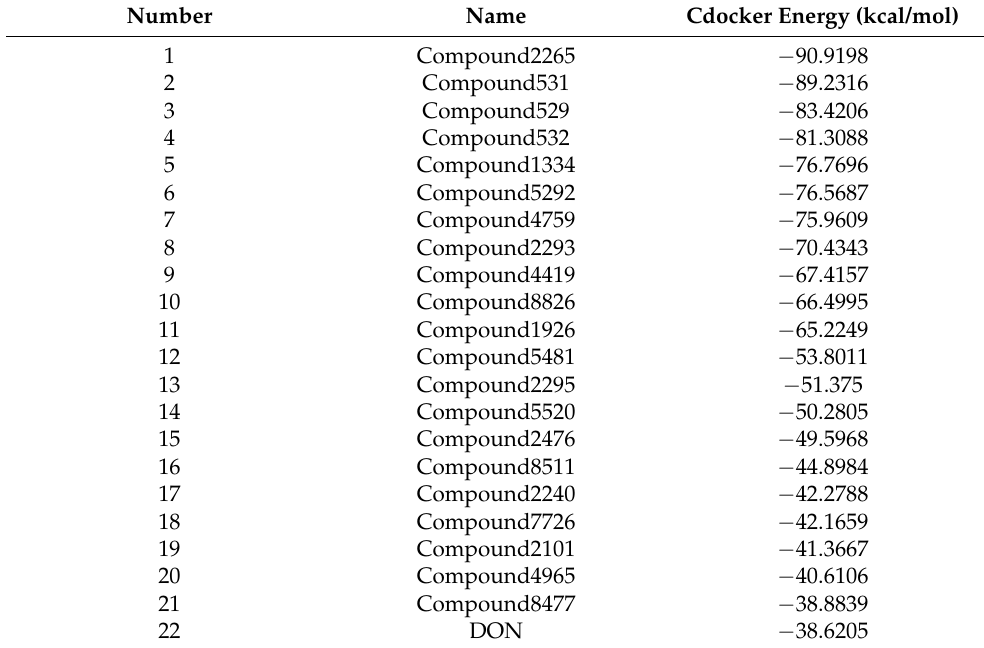
Table 2. CDOCKER potential energy of compounds with C Las GMPS.